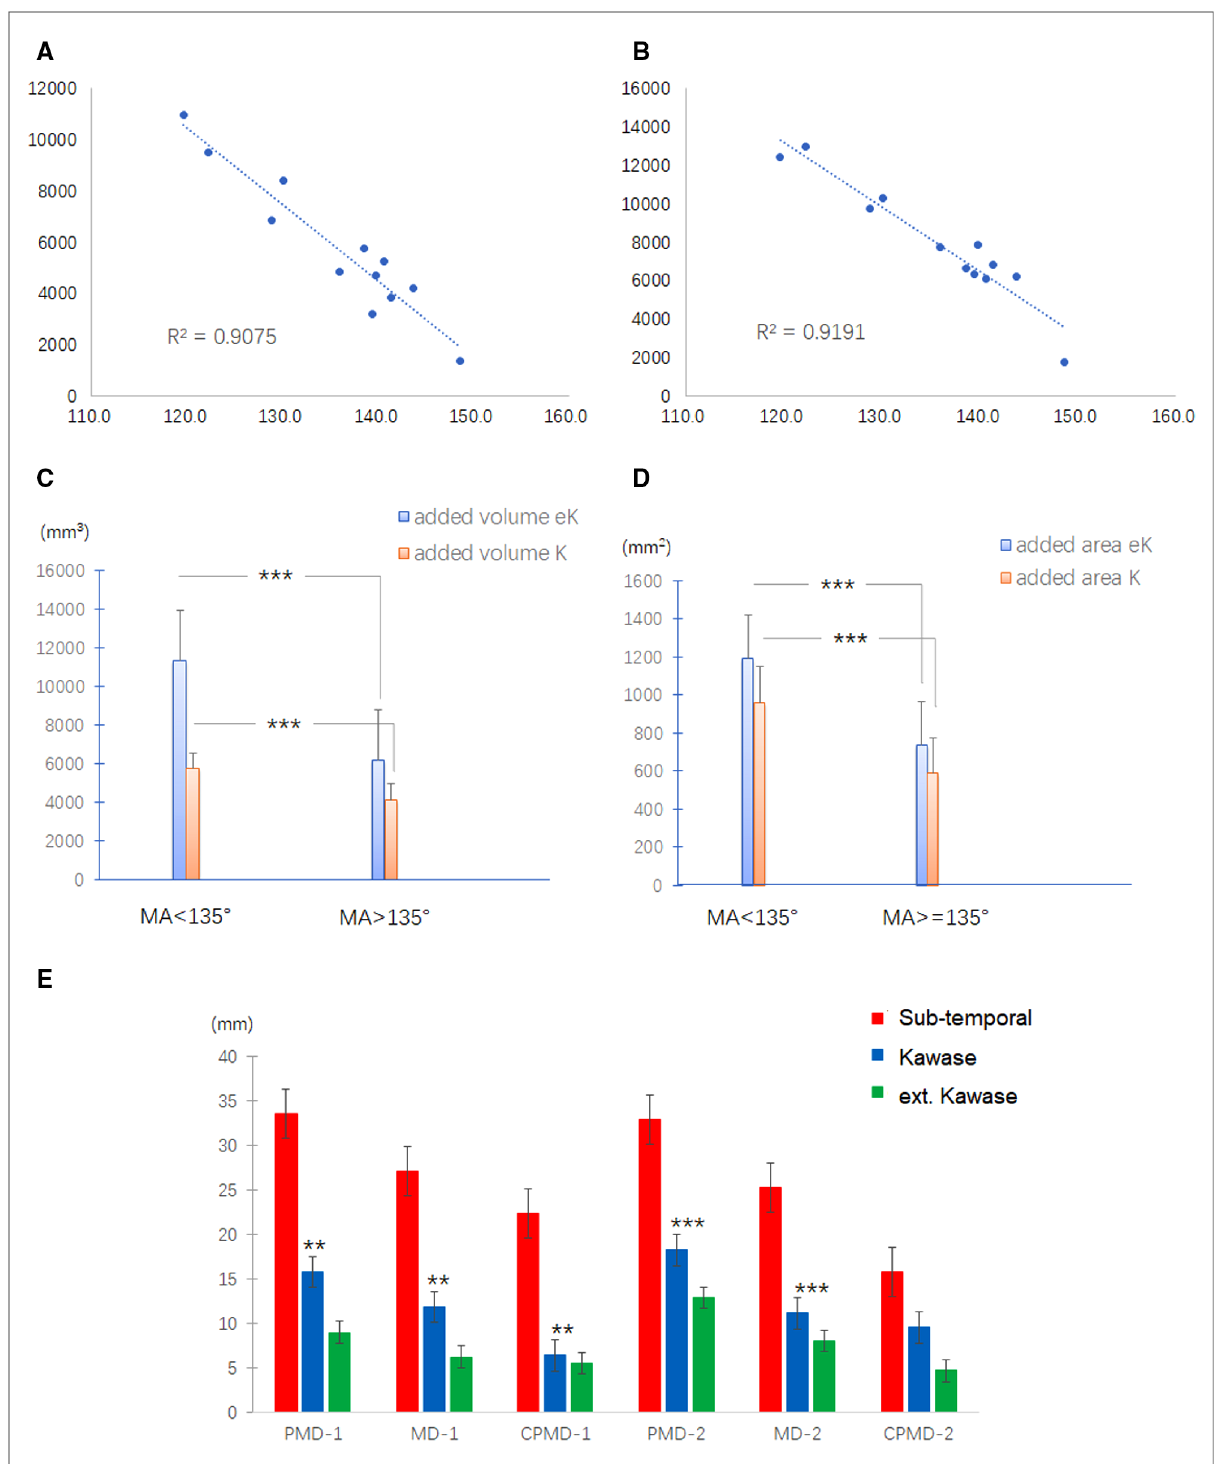
FIGURE 4 Correlation between the exposure range and the skull base anatomy. ( A,B ) Relationship between MA and added exposure volume for Kawase ( A ) and extended Kawase ( B ) approaches. ( C,D ) Exposure gains in the volume are higher in the Kawase approach or extended Kawase approach in group 1 (MA<135°) than those in group 2 (MA ≥ 135°) ( P <0.01) ( C ). Similarly, the added exposure areas are larger in the Kawase or extended Kawase approach when MA is less than 135°( P <0.01) ( D ). ( E ) De fi nitions of MD, PMD, and CPMD. The midline is the line between the basion and the crista galli; the para-middle line is the line parallel to the midline and across the anterior edge of the JT (MD, midline; PMD, para-middle line; CPMD, contralateral para-middle line). ( F ) Inferior limits for subtemporal (red column), Kawase (blue column), and extended Kawase (green column) approaches in MD, PMD, and CPMD of group 1 (MA<135°) and group 2 (MA ≥ 135°). MA, manipulation